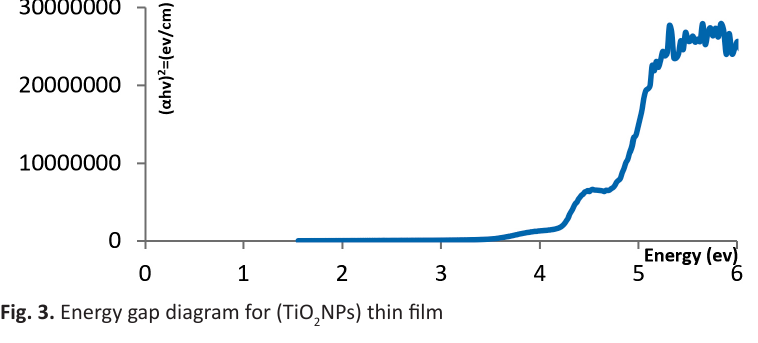
NPs) thin film 2